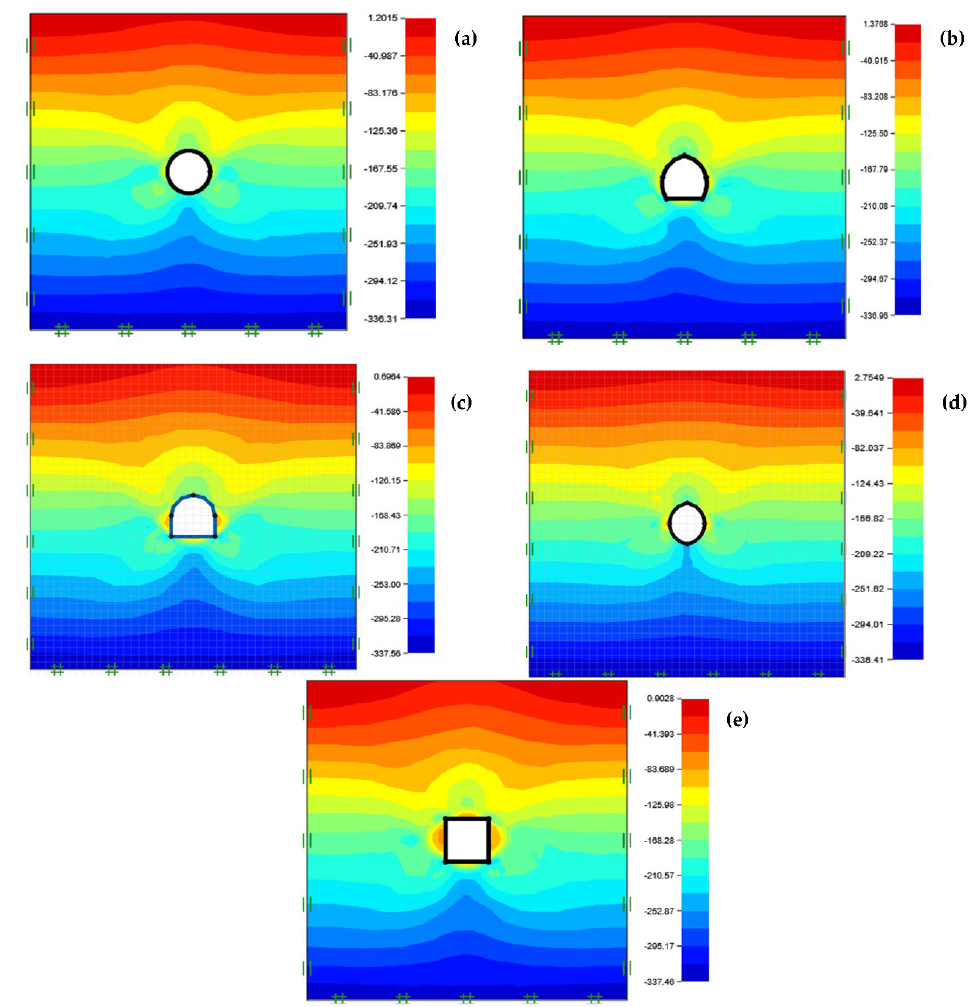
Figure 14. Principal stresses ( σ xx ) in soil having ( a ) circular-, ( b ) arch-, ( c ) horseshoe-, ( d ) elliptical-, and ( e ) square-shaped openings.